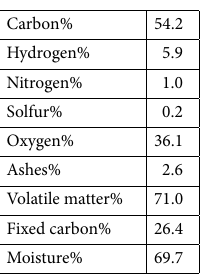
Table 2. CHN-S and proximate analysis of the feedstock.